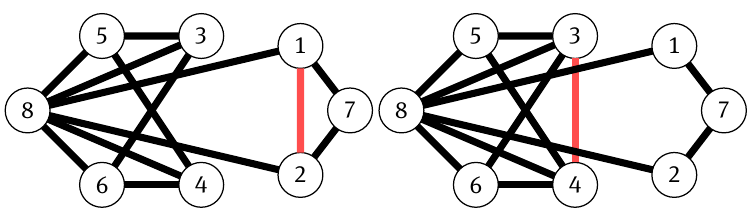
Figure 2: The only D L -cospectral pair on 8 vertices